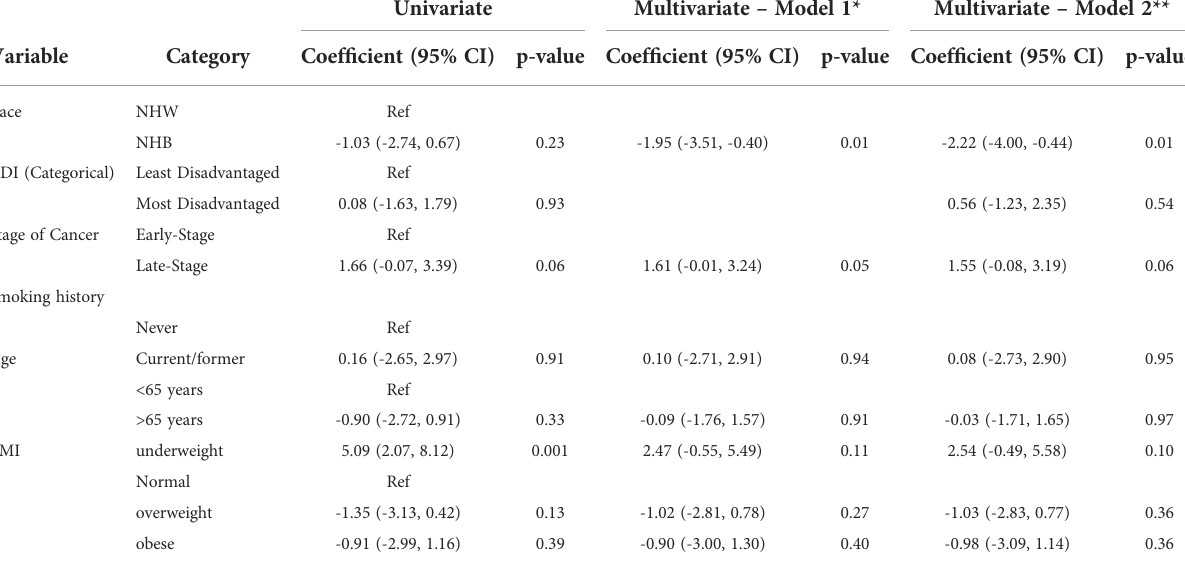
Table 2 details the association between demographics, clinical characteristics and NLR. In multivariable analysis, NHB race was TABLE 2 Univariate and adjusted linear regression estimates of the association between demographic and clinical characteristics and